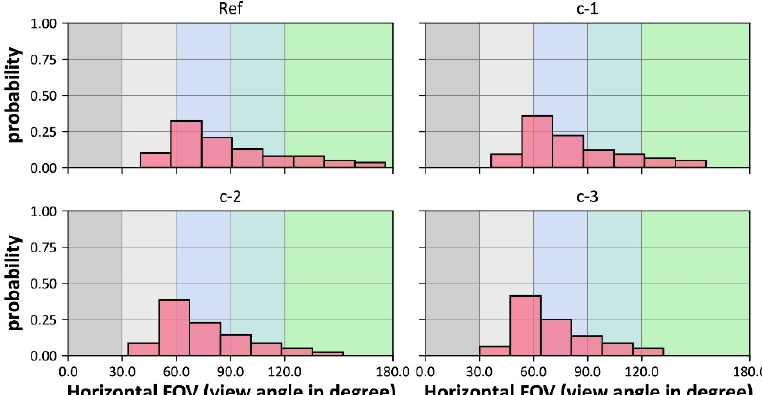
Figure A3. Impacts of dividing to multiple windows on the histograms of the overall FOVs for the case studies of scenario-b.